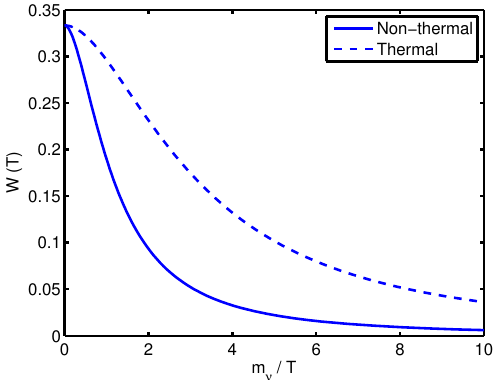
Figure 3. Equation of state compared to